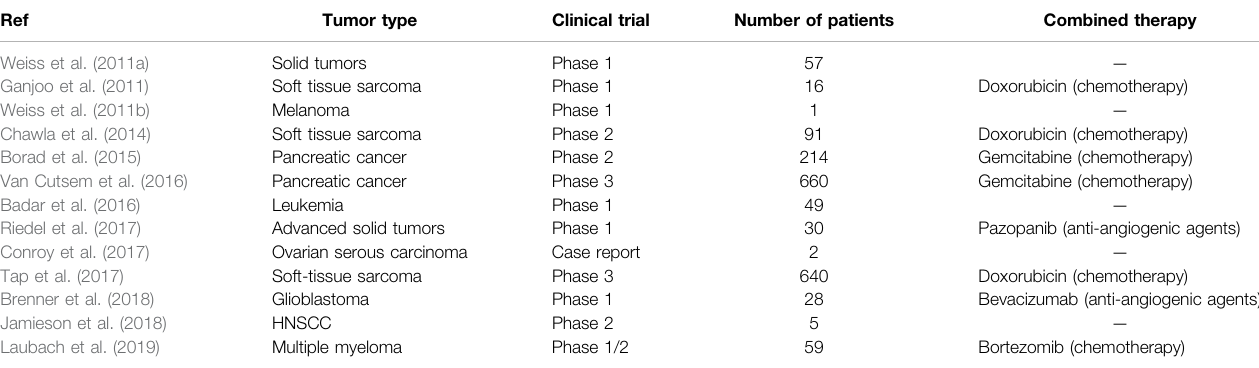
TABLE 2 | Clinical trials of